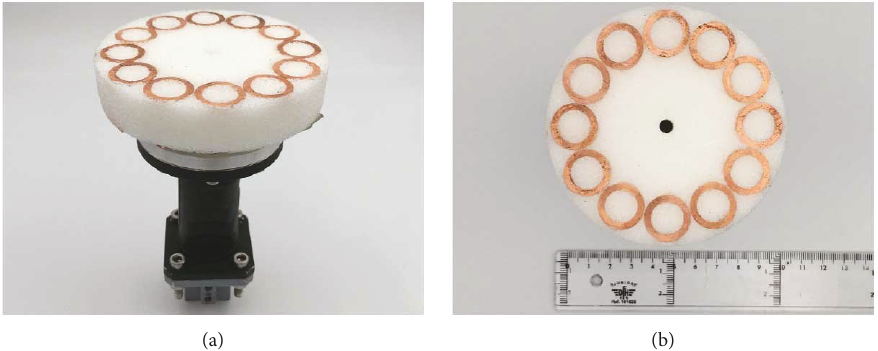
Figure 7: Pictures of the fabricated prototype: (a) complete structure and (b)